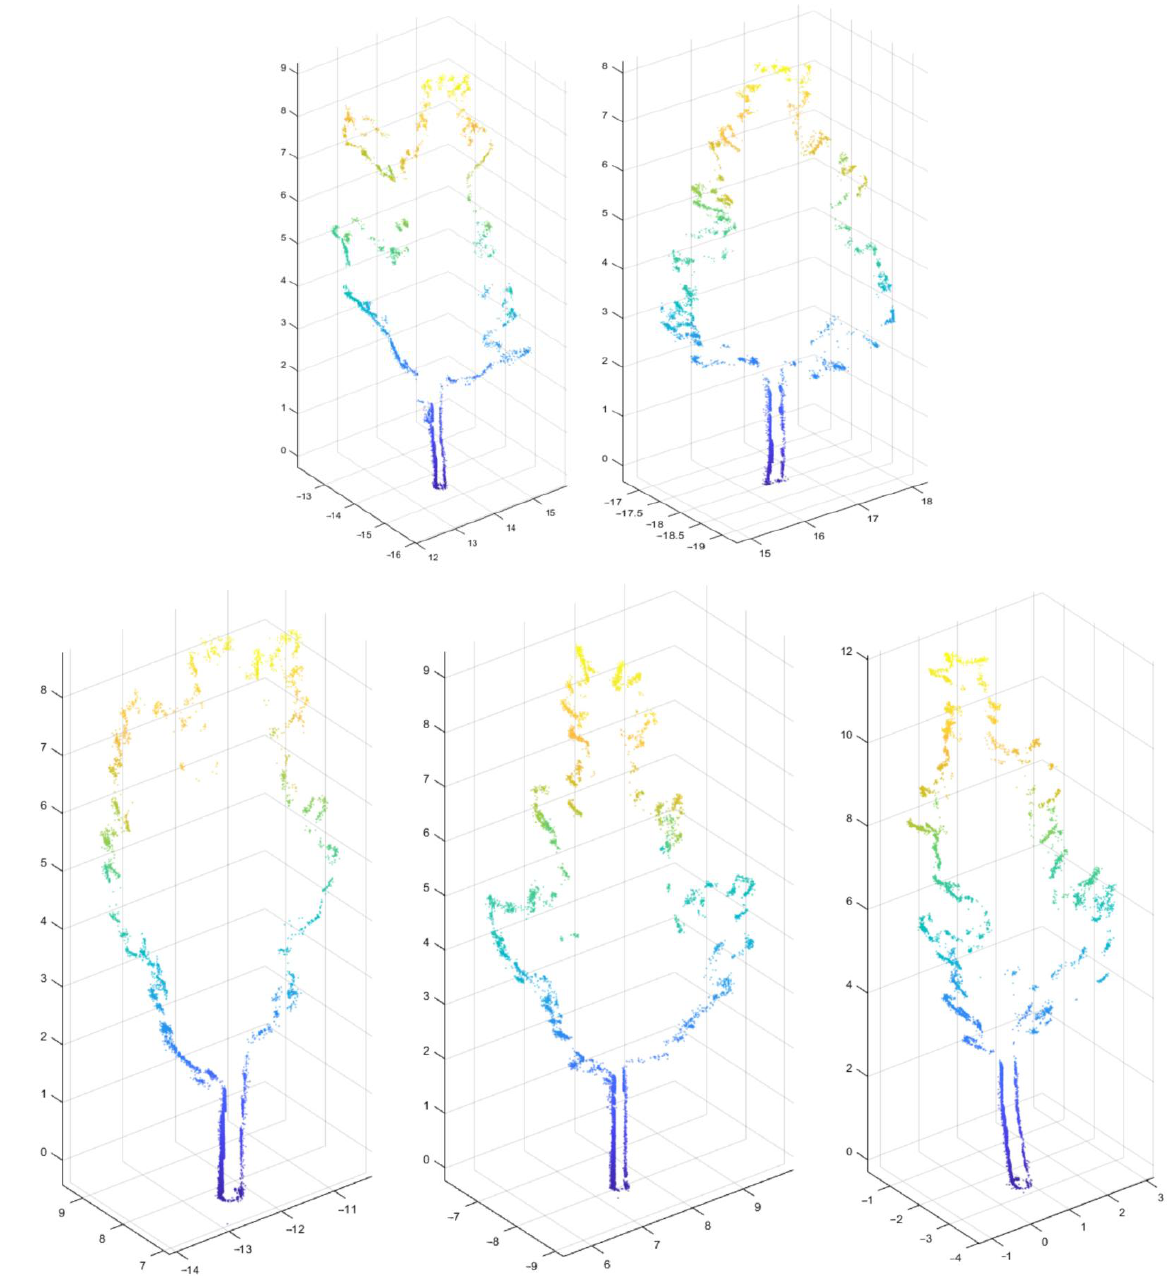
Figure 12. Segmentation precisions of 10 trees randomly selected from the experimental plot.